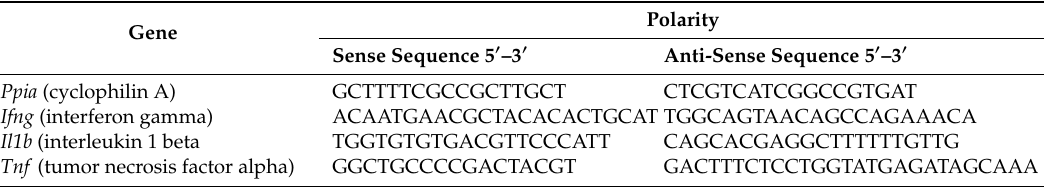
Table 1. Primer sequences of cyclophilin and